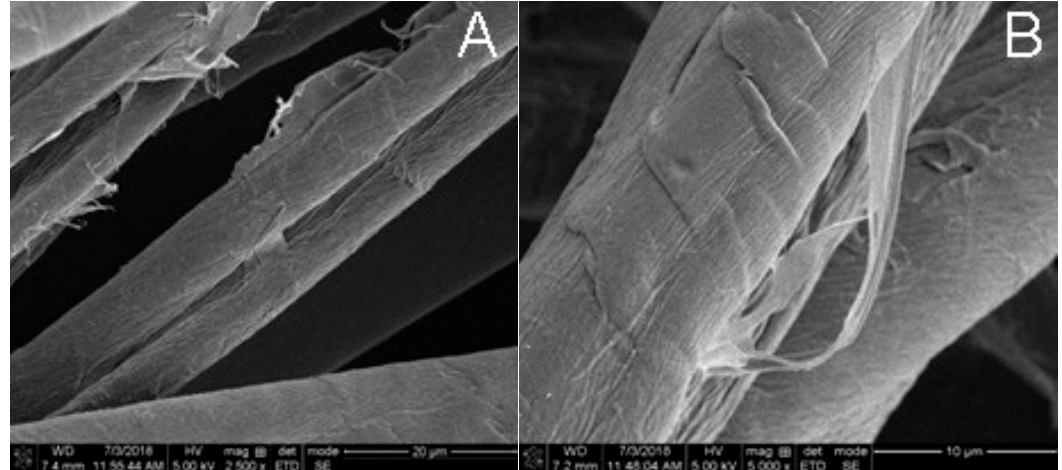
Figure 3. Samples 2 (image ( A )) and 4 (image ( B )) showing fibrillation and the partial separation of cotton fiber cuticle wax as a result of hydroentanglement. Table 1. Composition and L*a*b* Whiteness Measurement of Hydroentangled Nonwoven Rolls.